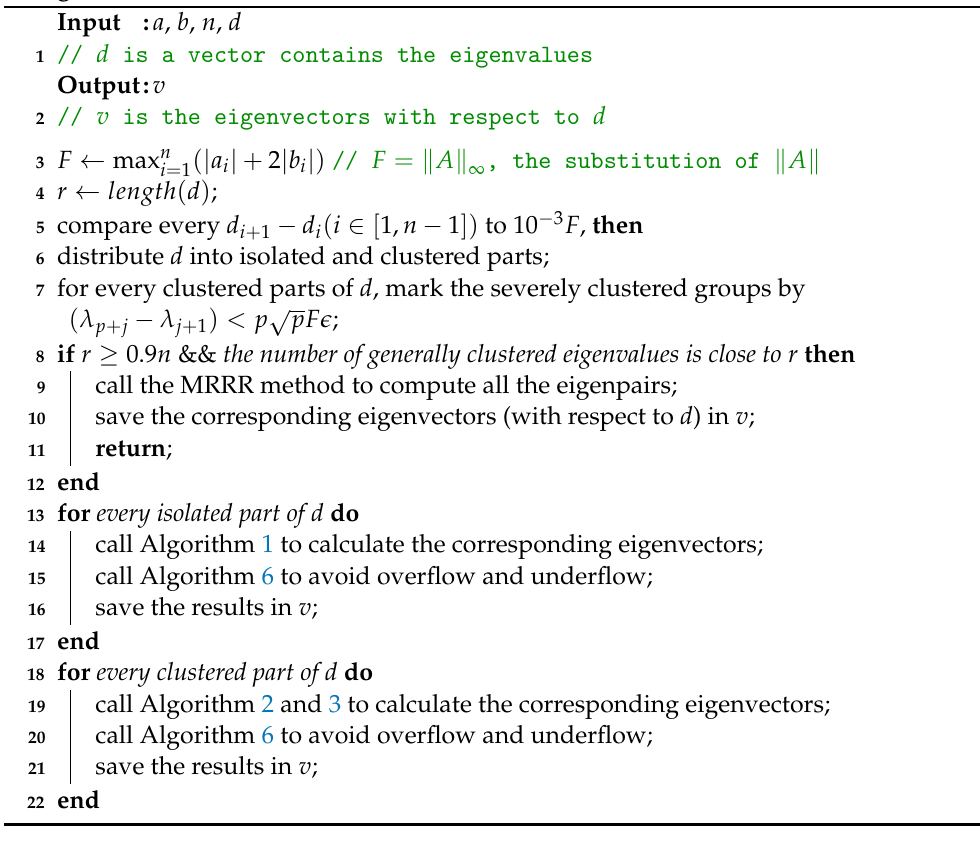
Algorithm 7: Modified Inverse Iteration